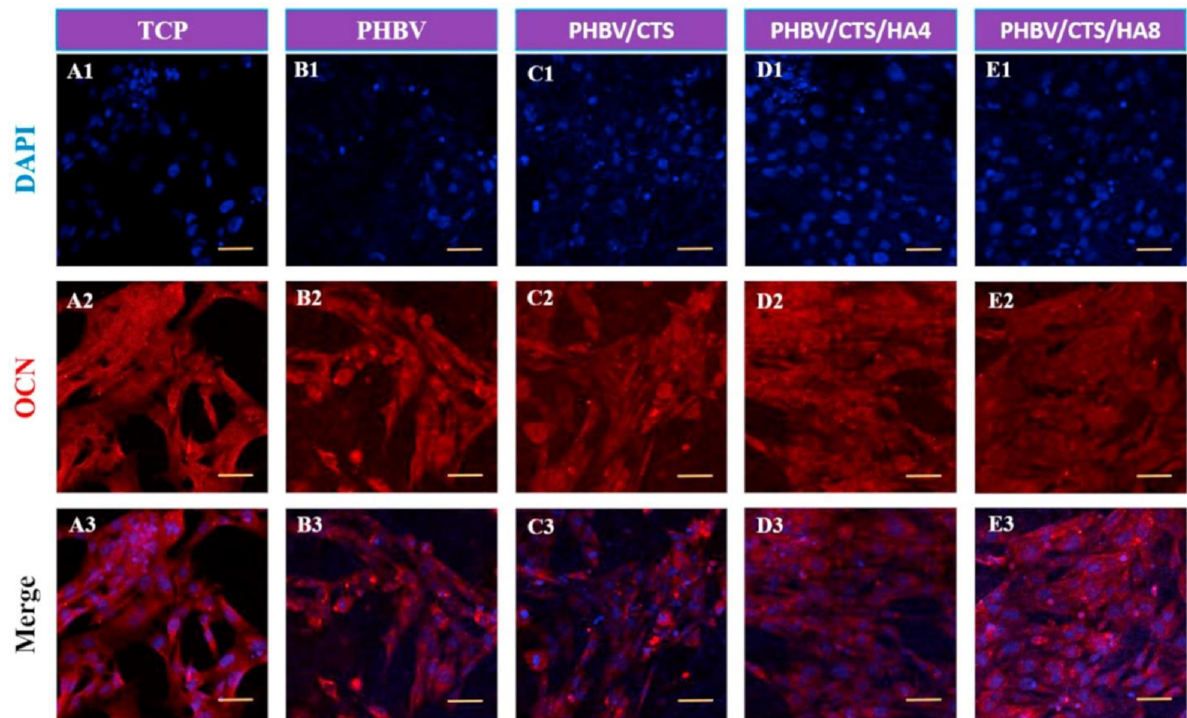
Figure 6. DAPI staining ( A1 – E1 ), expression of OCN ( A2 – E2 ) by human fetal osteoblasts and merge images ( A3 – E3 ) after culturing of cells for 5 days on TCP ( A1 – A3 ), PHBV ( B1 – B3 ), PHBV/CTS ( C1 – C3 ), PHBV/CTS/4 wt% nHA ( D1 – D3 ) and PHBV/CTS/8 wt% nHA ( E1 – E3 ). Reprinted from [135] with permission from